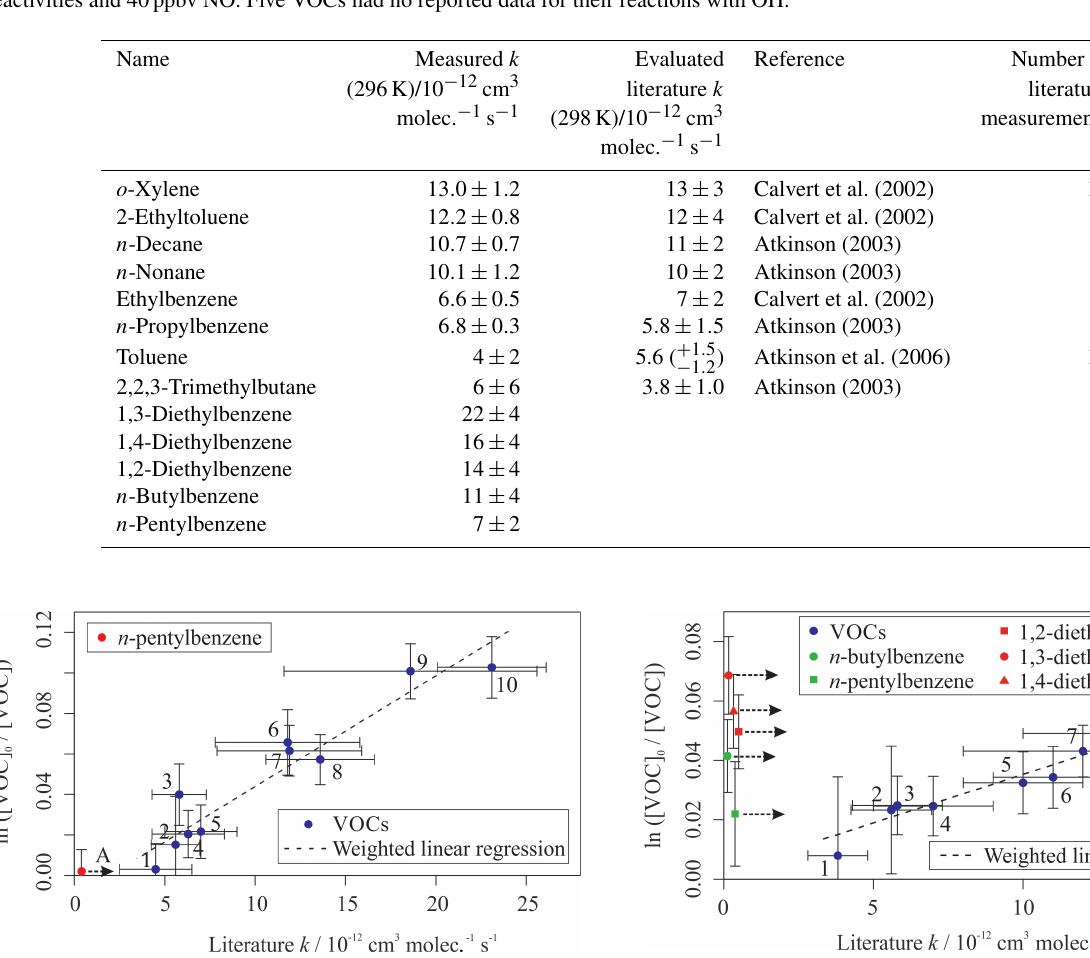
Figure 3. Relative rate plot for Mixture 3 (OH reactivity of 6s − 1 ) and 40ppb NO at 296 ( ± 2)K. Compounds with a reference rate coefficient for reaction with OH were plotted using evaluated lit- erature values. Error bars on the y axis, equal to 1 standard er- ror, were calculated by combining the standard error in peak ar- eas for eight lamp-off and eight lamp-on samples. Error bars on the x axis were typically large (approximately ± 20%–30%) and accounted for deviations from the predicted trend for most VOCs. A weighted (to the uncertainty in the y values) linear fit was used to generate the slope with OH exp = 3 . 3 ( ± 0 . 4 ) × 10 9 molec.cm − 3 s and R 2 = 0 . 890. Data for 1,2-, 1,3-, and 1,4-diethylbenzene and n -butyl and n -pentylbenzene were not used in the calculation of OH exp but were included on the plot to illustrate their measured de- pletion factors. The dashed arrows indicate that the k values for the target compounds are determined by where they would fall on the measured OH exp curve. The VOCs can be identified as follows: 1, 2,2,2-trimethylbutane; 2, toluene; 3, n -propylbenzene; 4, ethylben- zene; 5, n -nonane; 6, n -decane; 7, 2-ethyltoluene; 8, o